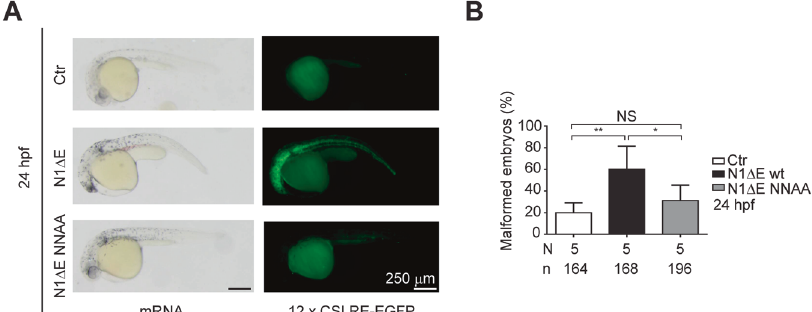
Fig. 4 Hydroxylation-resistant NICD1 is functionally less active. A The NICD1 NNAA mutant is less active compared to the NICD1 wild-type in zebra fi sh. Zebra fi sh embryos were injected with mRNA encoding for the membrane-bound Notch1 Δ E wild-type (N1 Δ E wt) or NNAA mutant (N1 Δ E NNAA). A reporter plasmid where the GFP-encoding gene is under the control of a Notch-dependent promoter was co-injected to monitor the NICD1 activity. B Quanti fi cation of malformed embryos shown in panel A . Shown are the means ± SD of the total number of embryos analyzed ( n ) in fi ve independent experiments ( N = 5). [*] P < 0.05, [**] P < 0.01, [NS] not signi fi cant (nonparametric Mann – Whitney U